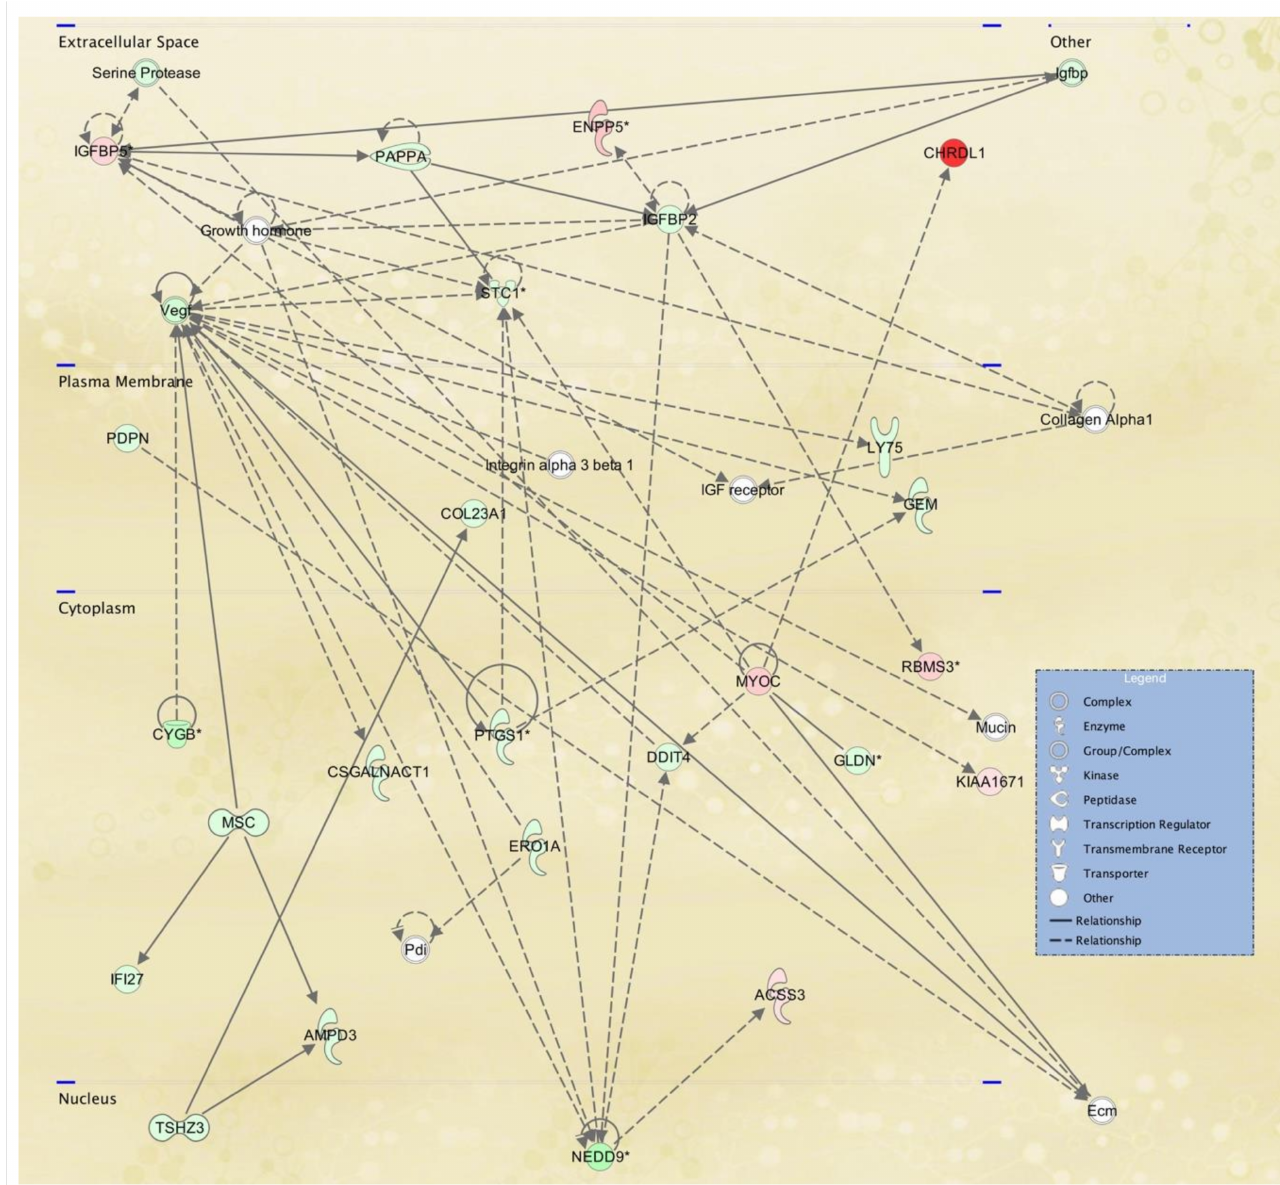
Figure 4. Cell signaling, free radical scavenging, small molecule biochemistry IPA network affected in SS fibroblasts. IPA network 5 includes chordin-like 1 (CHRDL1), a BMP4 antagonist that prevents its interaction with receptors as well as vascular endothelial growth factor (VEGF), which is down-regulated, and is the principal angiogenic growth factor modulating